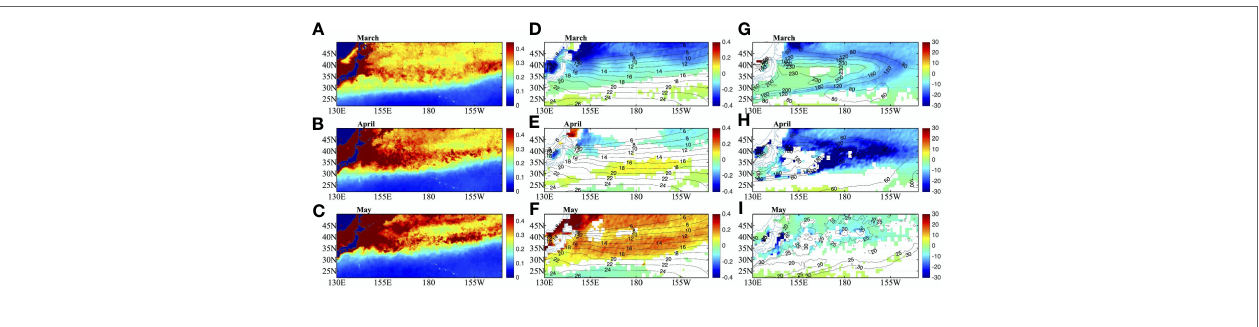
FIGURE 4 | Climatological mean of SeaWiFS chlorophyll concentration (mg m -3 ) for (A) March, (B) April and (C) May. Shaded in (D–F) are for SST differences between CLIMCHL and NOCHL, and contours are for SST of NOCHL (°C). Shaded in (G–I) are for MLD differences between CLIMCHL and NOCHL, and contours are for MLD of NOCHL (M). SST and MLD differences are at 95% significant level.